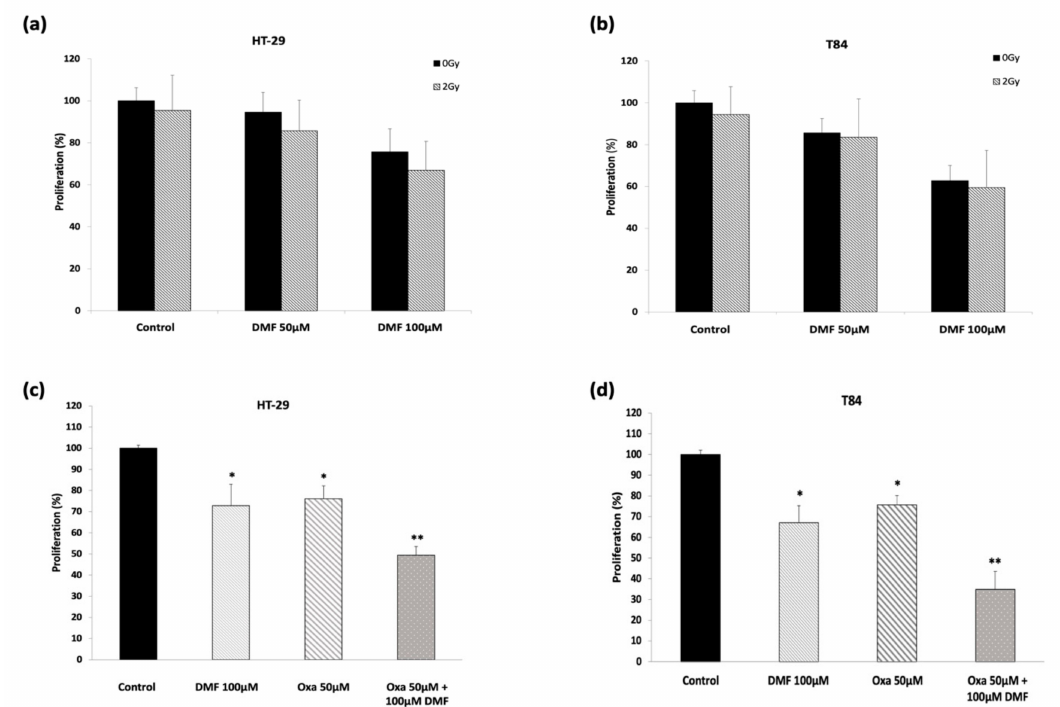
Figure 7. Combinational treatment with DMF and radiation or oxaliplatin. Proliferation assay for the DMF / radiation treatment ( a ) HT-29 and ( b ) T84 cell lines. DMF pretreated cells (3 h) were exposed to 0 Gy vs. 2 Gy and incubated for additional 21 h for an overall treatment timed of 24 h. Proliferation assay for DMF / oxaliplatin treatment in ( c ) HT-29 and ( d ) T84 cell lines. Oxaliplatin was added 2 h after pre-incubation with DMF or solvent, respectively, at indicated concentrations for another 22 h. Mean values from at least three independent experiments are shown as mean ± SD. p < 0.05: significant. * significant compared to untreated control. ** significant compared to single treatments and untreated